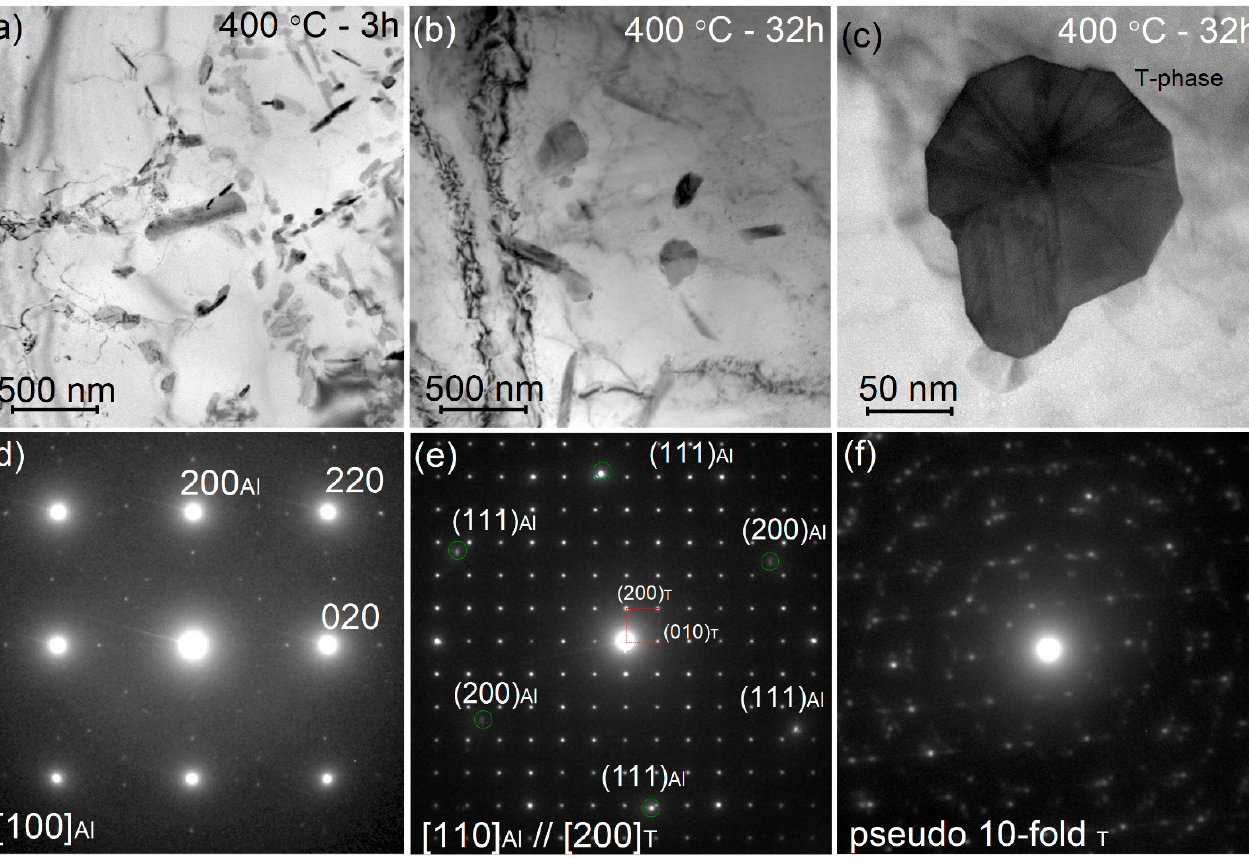
Figure 7. ( a – c ) Bright field TEM images and corresponded SAEDs for the Al-2%Cu-2%Mn alloy subjected to aging for ( a , d ) 3 h, ( b , c , e , f ) 32 h at 400